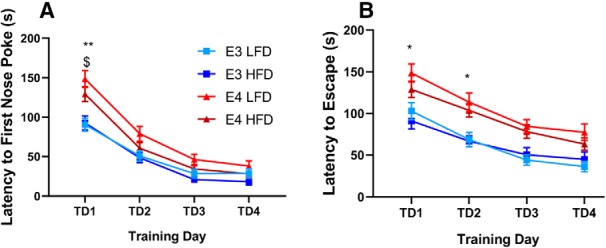
Effects of diet on BM performance. Mice were trained on the BM for four consecutive days, and memory acquisition was measured. Latency to first nose poke of the escape hole (A). Latency to escape from the BM (B). A, B, N = 13–15; *p < 0.03; $p < 0.05, **p < 0.004, two-way ANOVA, Sidak’s multiple comparison test.